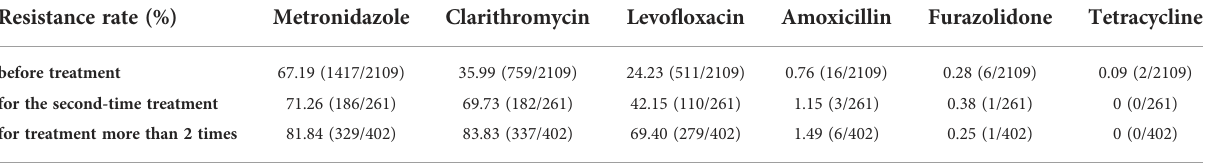
TABLE 1 Antibiotic resistance rates of H. pylori before treatment or after different times of treatment in Nanjing, China. Resistance rate